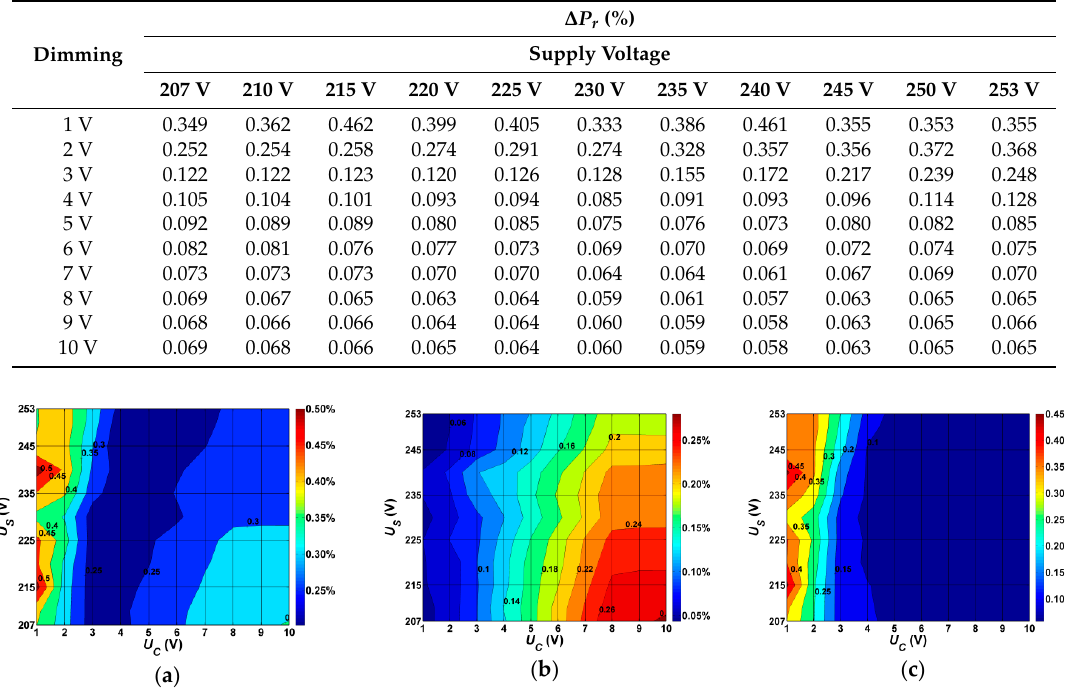
Δ P r (%) Supply Voltage ∆ P r (%)